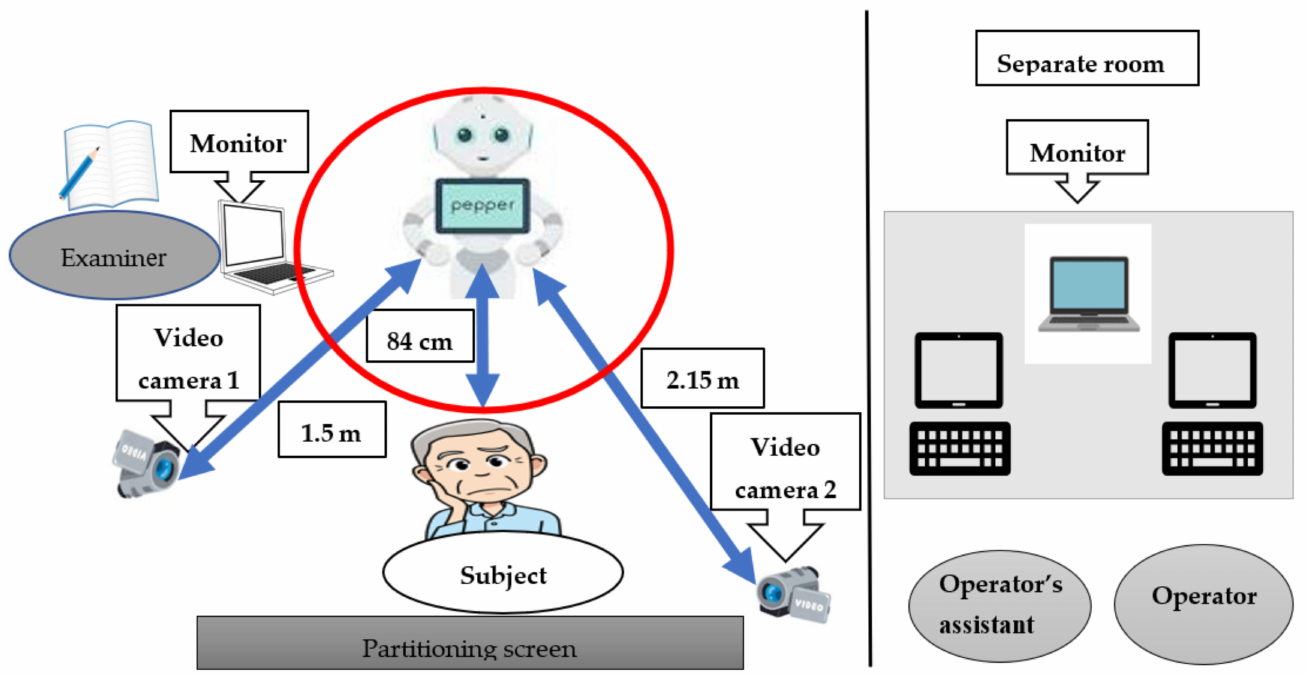
Figure 2. Experimental environment. The blue arrows indicate the distance from the Pepper robot to the digital video